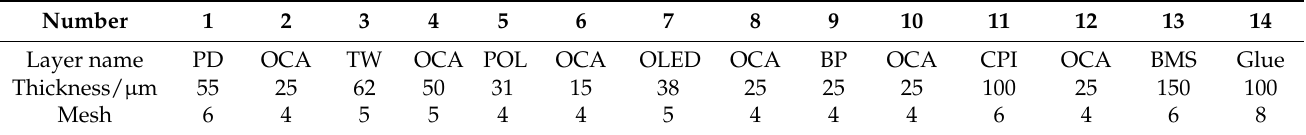
Table 1. Sequence of stacking.